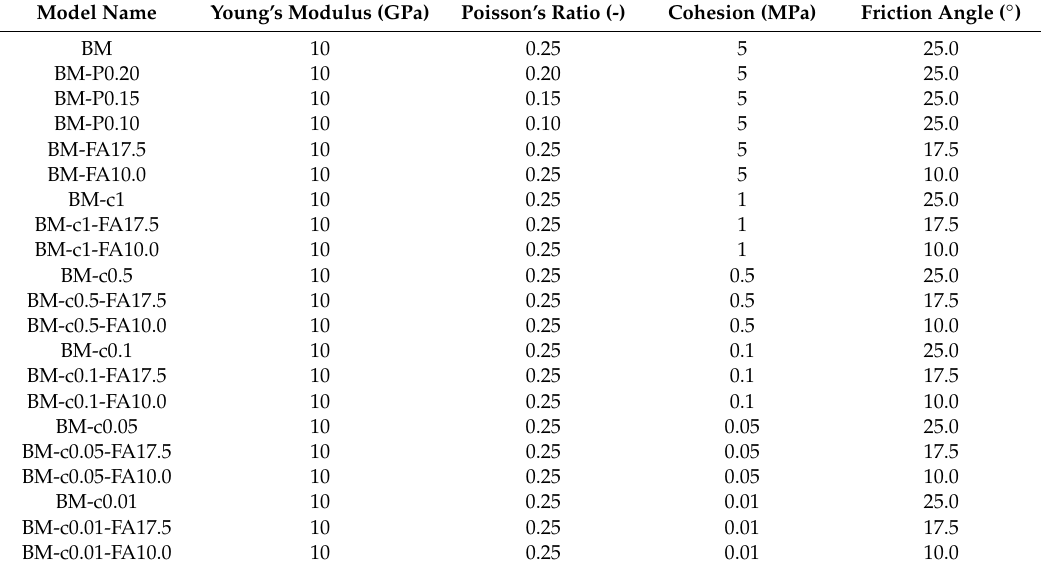
Table 2. Overview of the 87 scenarios studied and the corresponding model names. The scenarios di ff er regarding the elastic and the frictional properties assigned to the model unit representing the fault